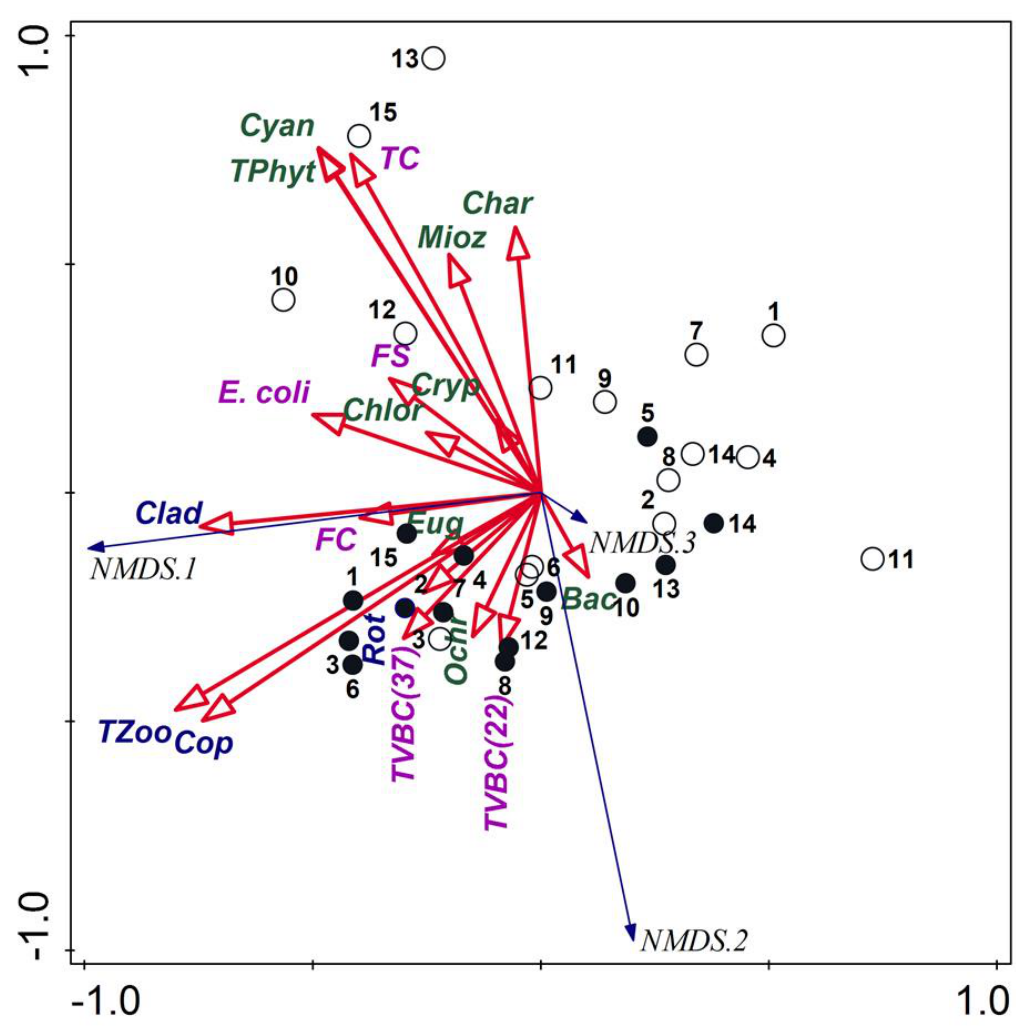
Figure 4. NMDS triplot based on planktonic organisms; empty circles—samples from the post-flood period,